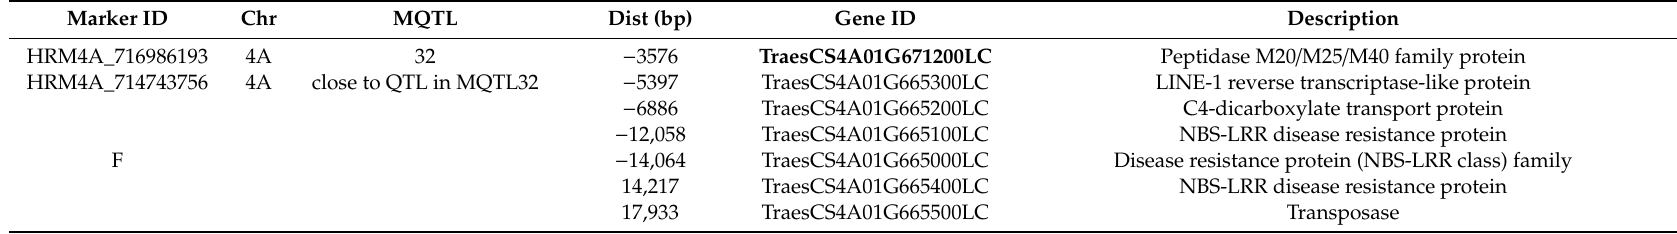
Table 4. Drought responsive candidate genes tagged by the developed HRM-ISBP markers. DE genes are shown in bold and di ff erentially expressed genes are indicated with “*”. Gene expression responses to drought treatments are shown in Figures 5 and 6, and Tables 3 and 4. The positive and negative “Dist” column values indicate if the corresponding gene is downstream or upstream of the